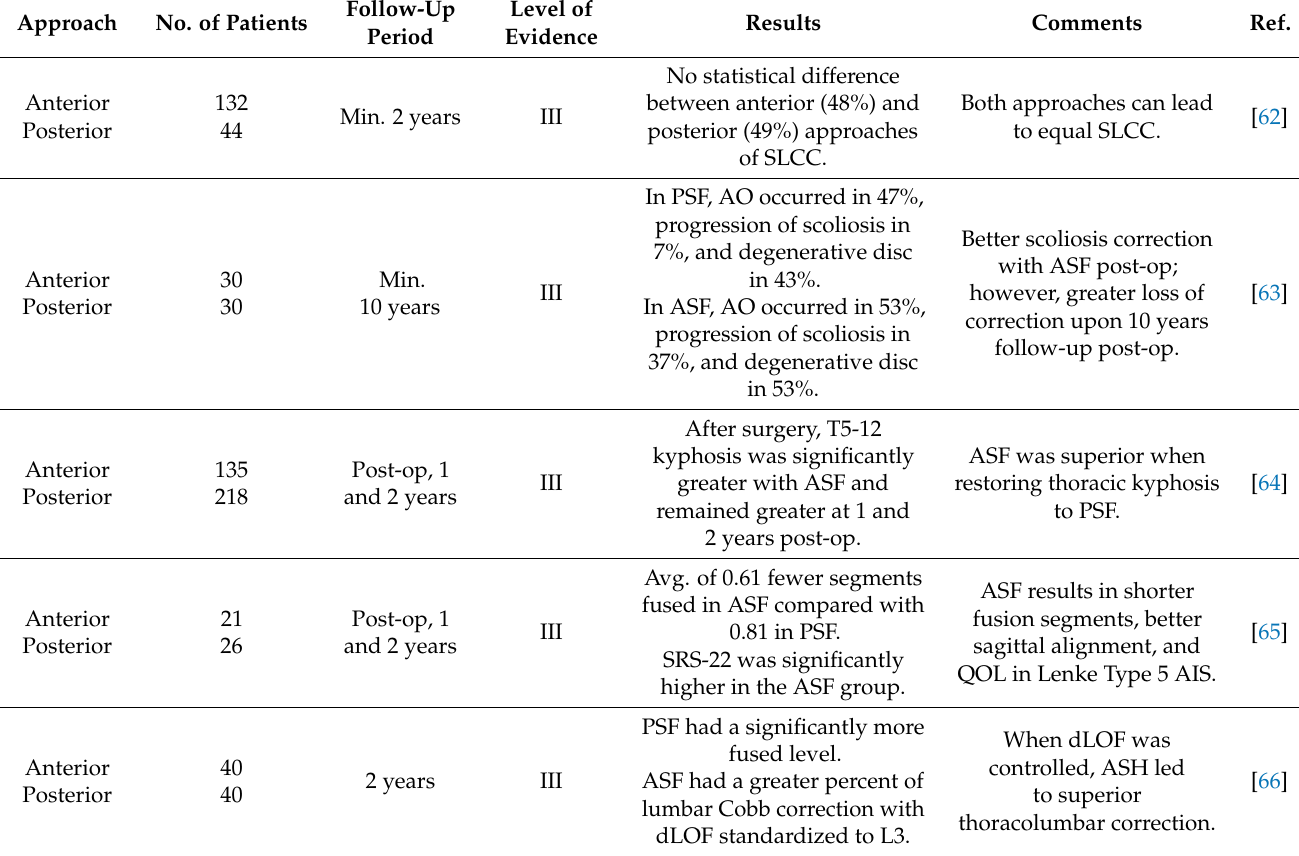
Table 5. Outcomes and comparison of different spinal fusion in scoliosis. Modified from